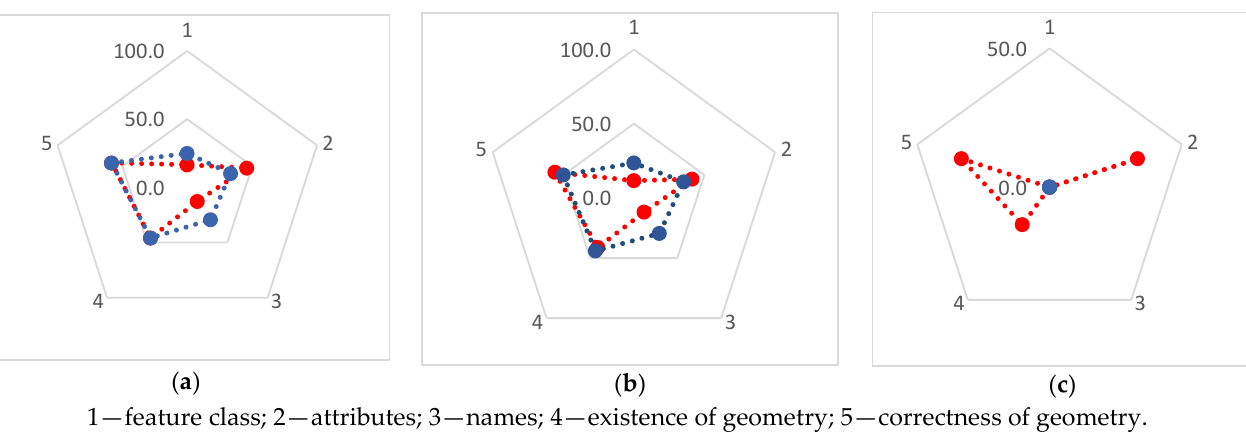
Figure 9. Percentage of points for Oriental/Japanese-style park: ( a ) level 1; ( b ) level 2; ( c ) level 3.